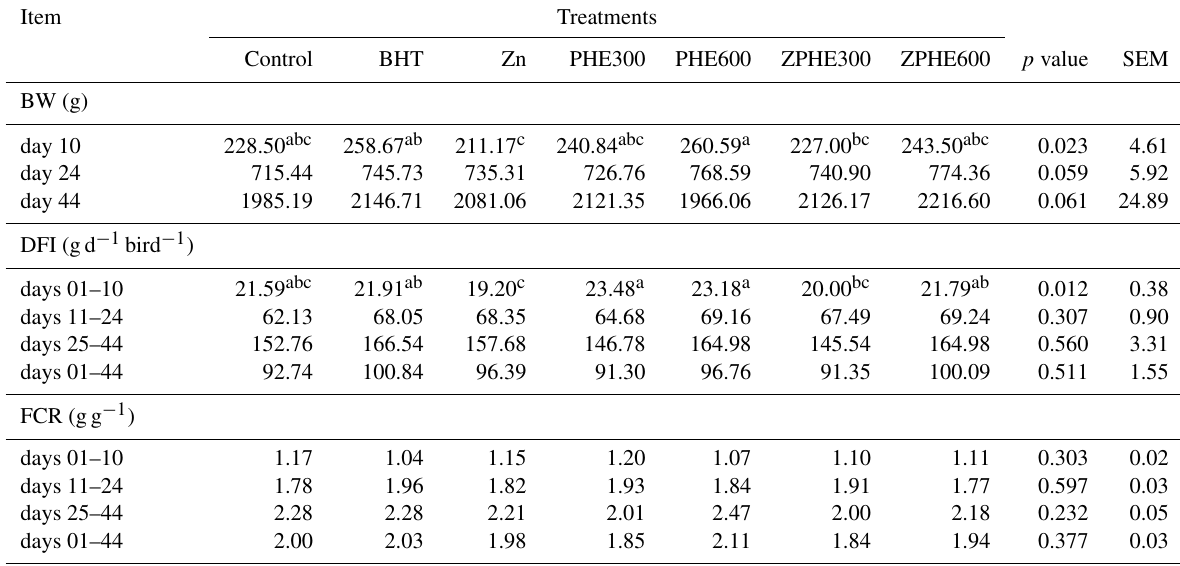
Table 2. Effects of dietary Zn and PHE on performance of broiler chickens from 1 to 44 days of age. a-c indicates that results with the same superscript in each row are not significantly different.